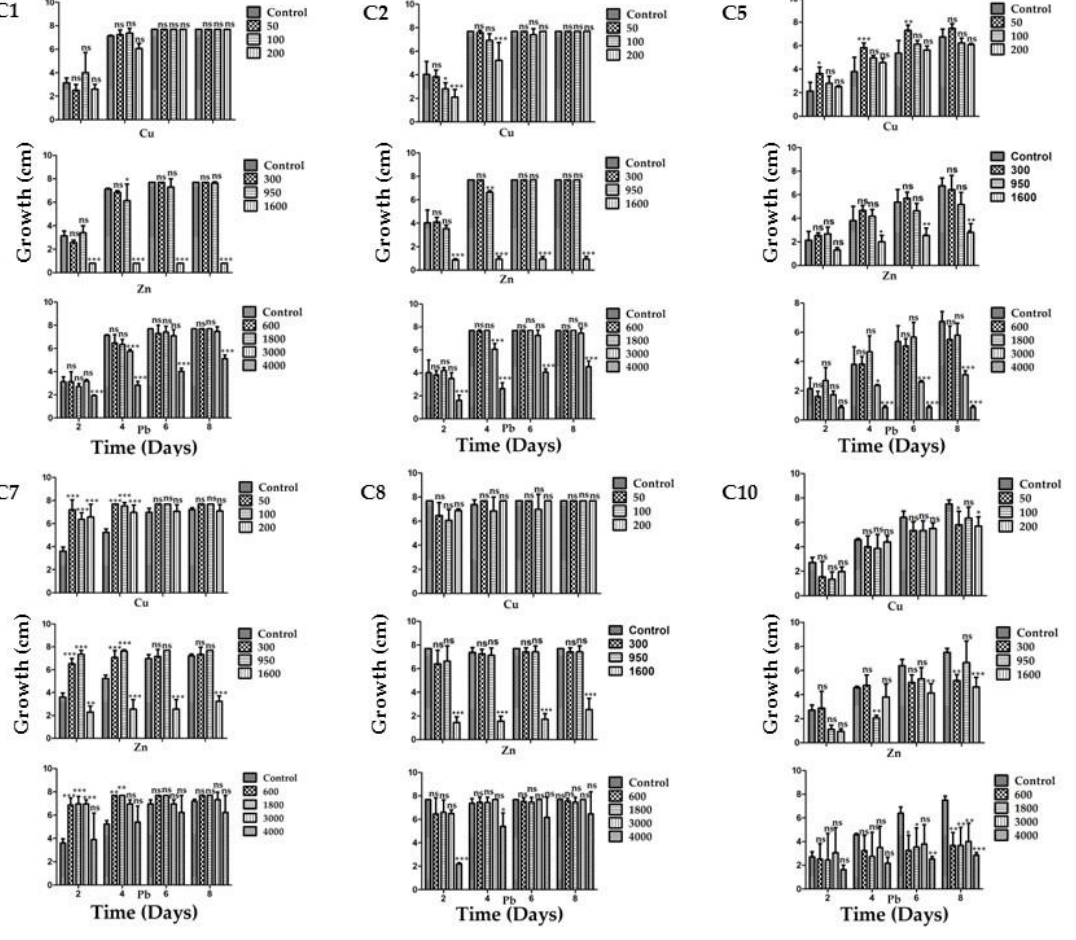
Figure 2. Minimum inhibitory concentration for the six most tolerant strains isolated from P. laevigata roots in each of the three metals tested. The strain ’ s code is depicted at the upper left corner for each group of three graphs, which includes one for each metal (Cu, Zn and Pb). * = p < 0.05, ** = p < 0.01, *** = p < 0.001, ns = no significant difference.